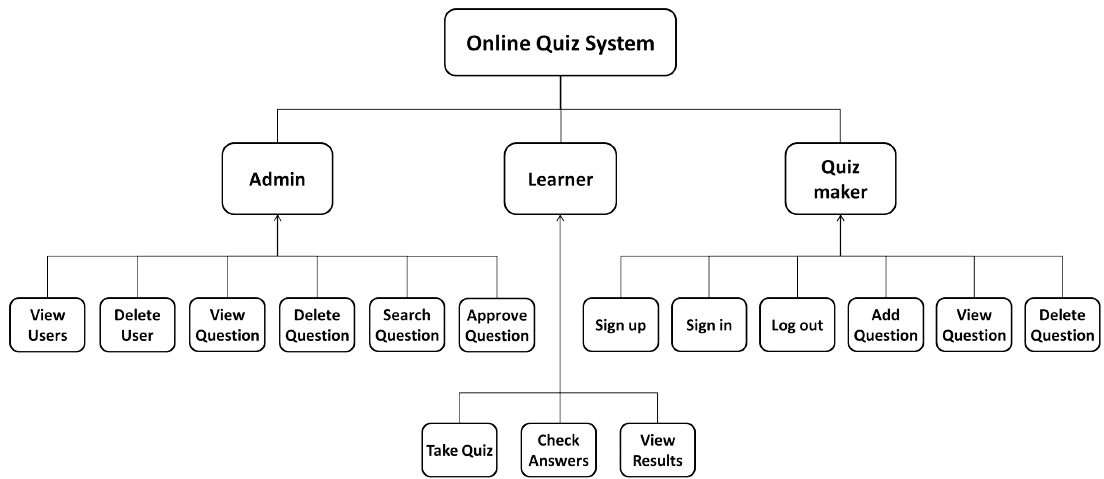
Figure 4. Decomposition of web-based online quiz